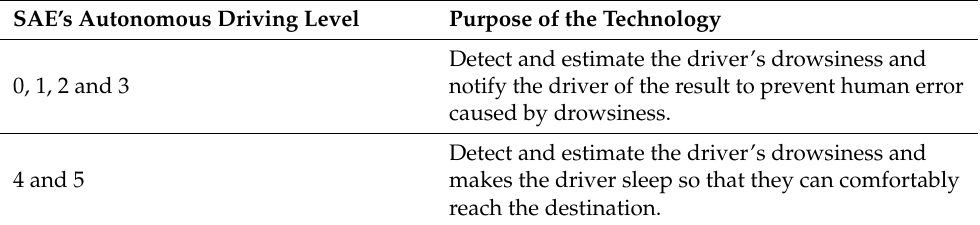
Table 6. Summary of the prospects of arousal level detection and estimation technology for au- tonomous